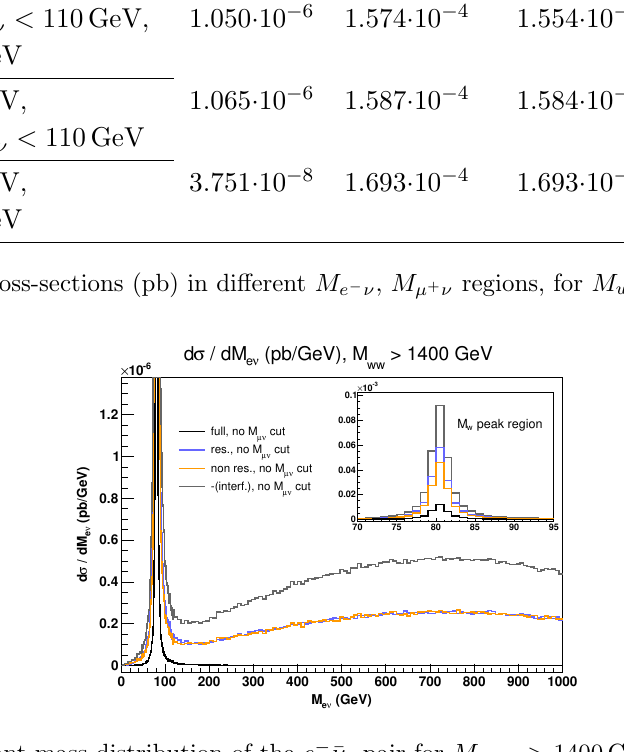
Figure 12. Invariant mass distribution of the e (cid:0) (cid:22) (cid:23) e pair for M WW > 1400 GeV in the SM results. No cuts on